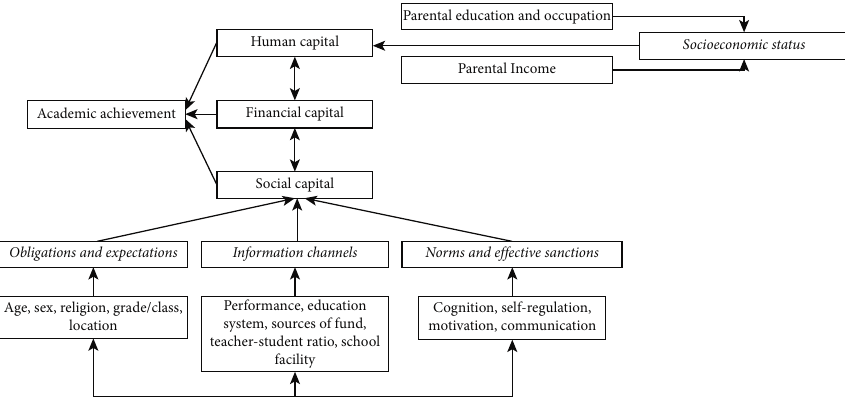
Figure 1: Conceptual framework based on Coleman’s [21] social capital